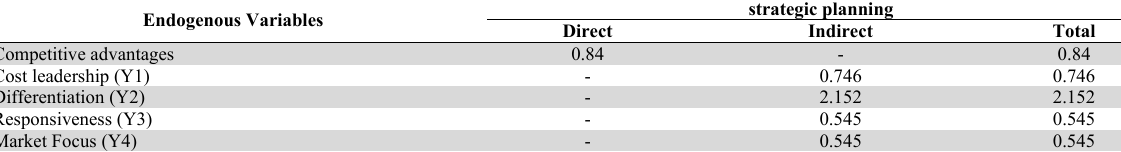
Direct and indirect effects of strategic planning on competitive